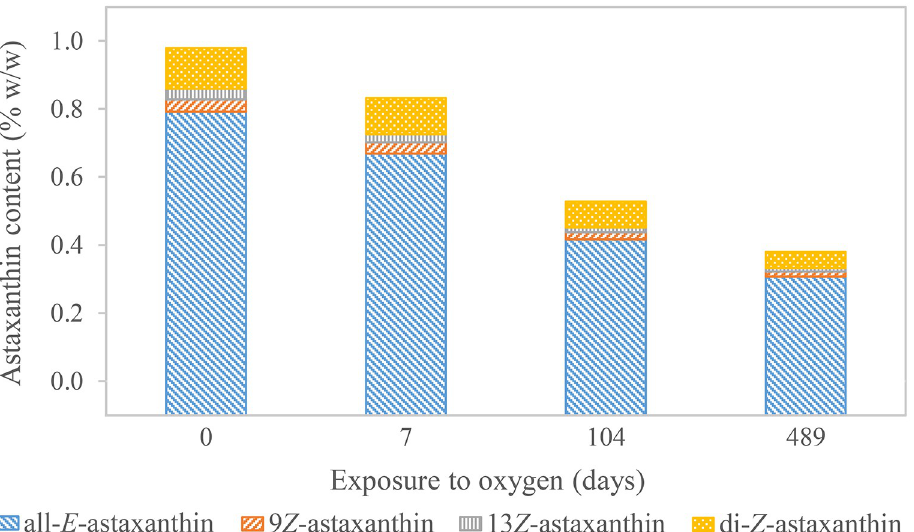
Fig 10. Astaxanthin content in lyophilized H . pluvialis biomass. It was exposed to ambient atmosphere for different periods of time and measured after 489 days.